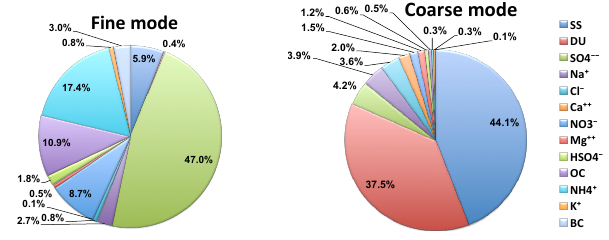
Figure 2. Aerosol mass fractions based on two years of model results for CUT-TEPAK in Cyprus.